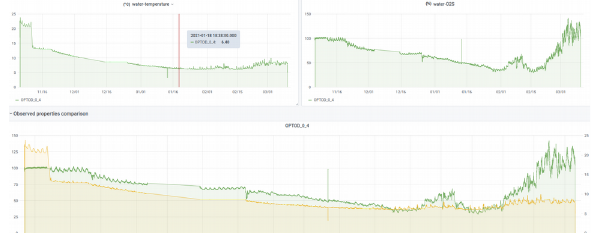
Figure 6 . Graphs produces by the web user interface showing water temperature (°C) and DO data (as % saturation) at 0.4